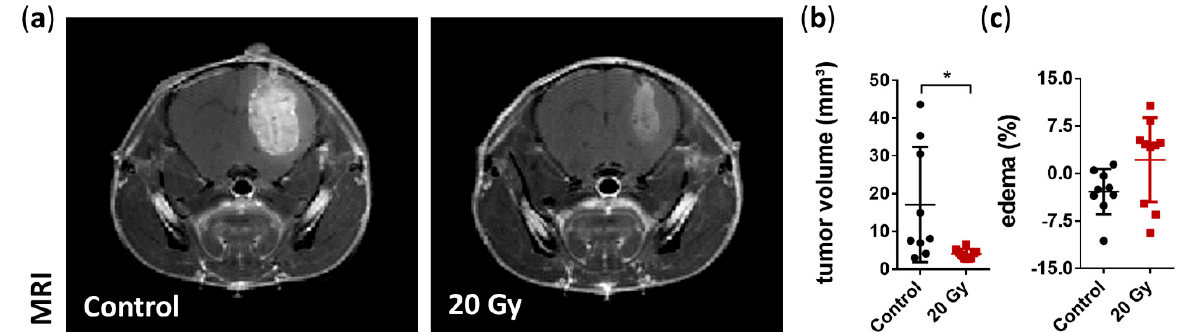
Figure 3. MRI assessment of the tumor volume and peritumoral edema at day 21. ( a ) Representative coronal MRI T1-weighted images with contrast agent highlighting the smaller tumor following irradiation. ( b ) Volumetric analysis demonstrated a significant reduction in tumor volume six days after irradiation treatment compared to non-irradiated tumors (data are presented as the mean ± SD of each group. Individual values of each animal are provided as a single dot; n = 9–10 per group; * p < 0.05). ( c ) Quantification of edema size showed no significant changes; however, a large variability within the irradiated group was observed. Edema was calculated as the difference in the tumor volume between the T2- and T1-weighted MRI images and presented as the percentage of total tumor volume (data are presented as the mean ± SD of each group. Individual values of each animal are provided as a single dot; n = 9–10 per